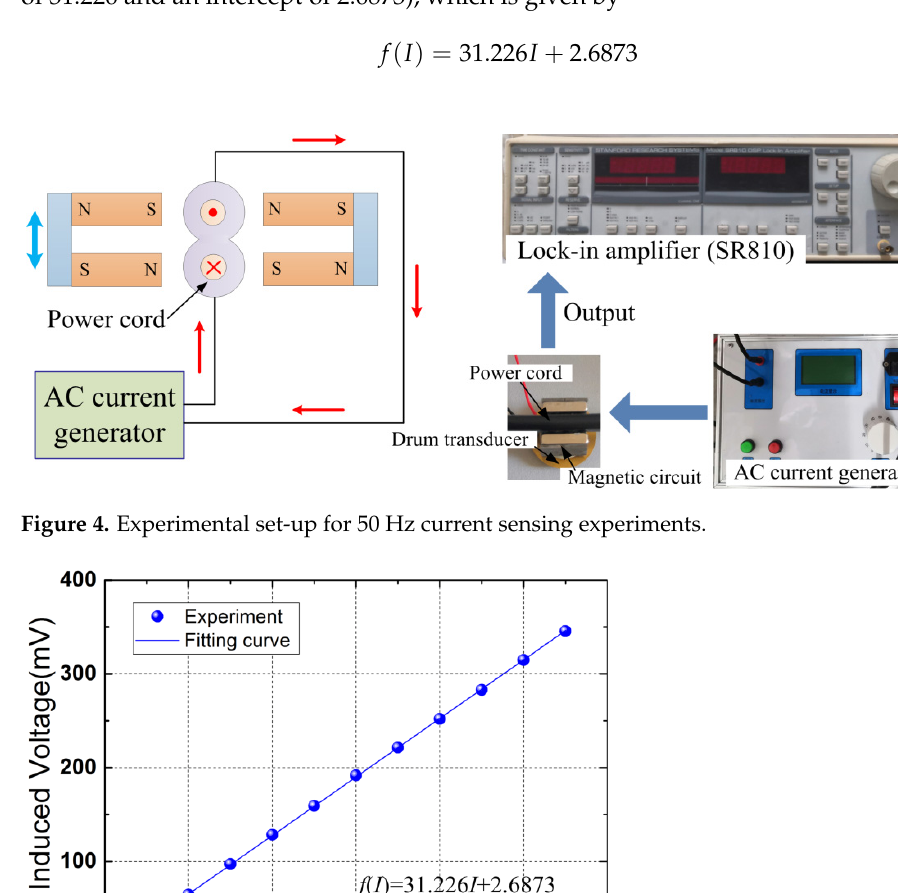
Figure 5. Induced voltage as a function of the current at the power frequency of 50 Hz.